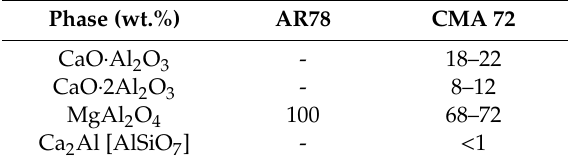
Table 1. Mineral composition of fine-grained AR78 ( − 90 µ m) and CMA 72 (cement). Phase